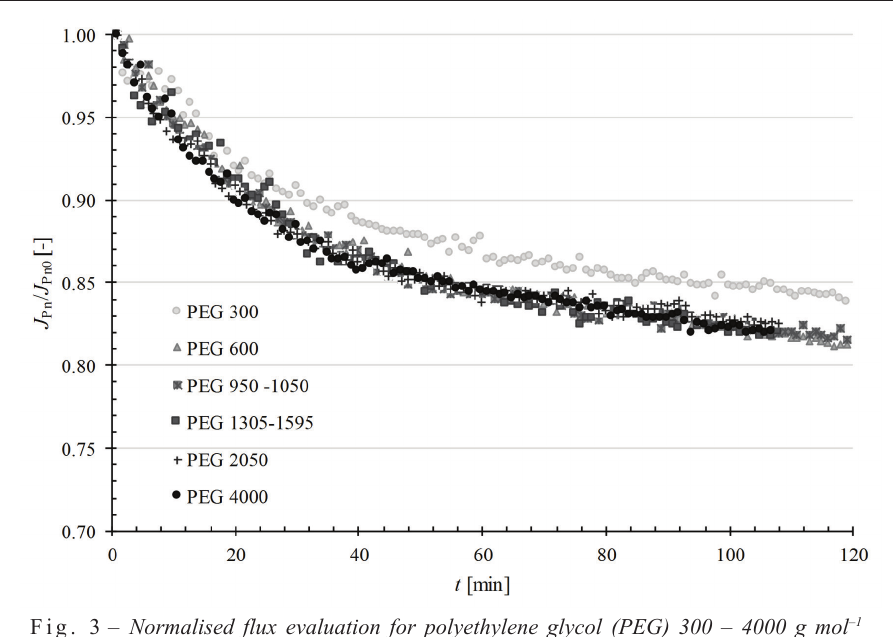
Fig. 3 – Normalised flux evaluation for polyethylene glycol (PEG) 300 – 4000 g mol –1